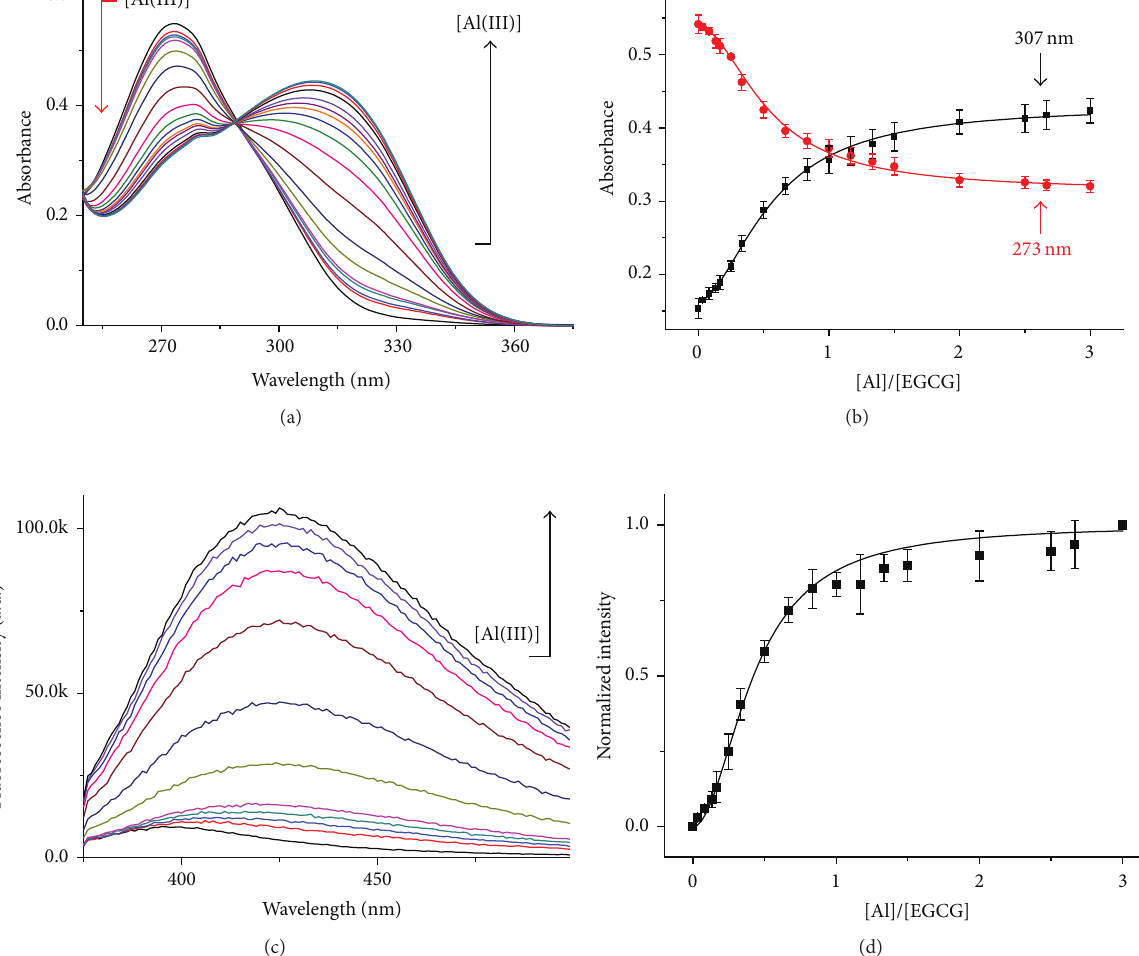
Figure 2: Chelation of Al(III) and EGCG. (a) UV spectra of 50 𝜇 M EGCG in the presence of Al(III) at various concentrations from 0 to 150 𝜇 M. (b) Dependence of absorbance of 50 𝜇 M EGCG at 273nm (red) and 307nm (black) on the molar ratios of Al(III) to EGCG from 0 to 3. The values represent mean ± SD ( 𝑛 = 3 ). (c) Fluorescence spectra of 150 𝜇 M EGCG as Al(III) concentration increased from 0 to 450 𝜇 M. (d) 150 𝜇 M EGCG fluorescenceintensity at 425 nm on molar ratio of Al(III) to EGCG. The intensity values were normalized to 150 𝜇 M EGCG with 450 𝜇 M Al(III). The values represent mean ± SD ( 𝑛 = 3